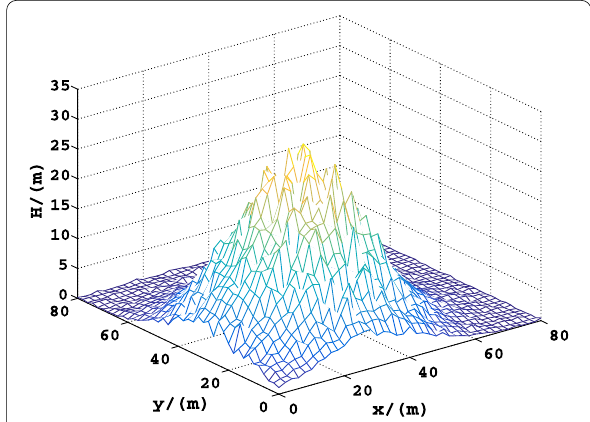
Fig. 9 DTM model disturbed by MREs with σ m = 0.1 in the third example